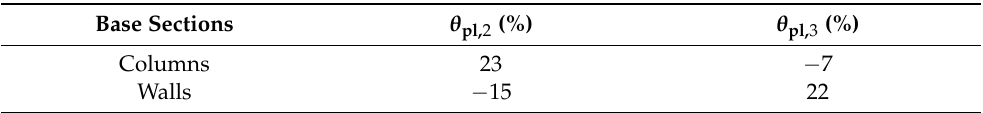
Table 9. Error (%) on the mean seismic plastic chord rotations θ pl,3 and θ pl,2 of the base sections of columns and walls of the case 2 building resulted by the “inelastic dynamic eccentricities” pushover procedure at the NC state.